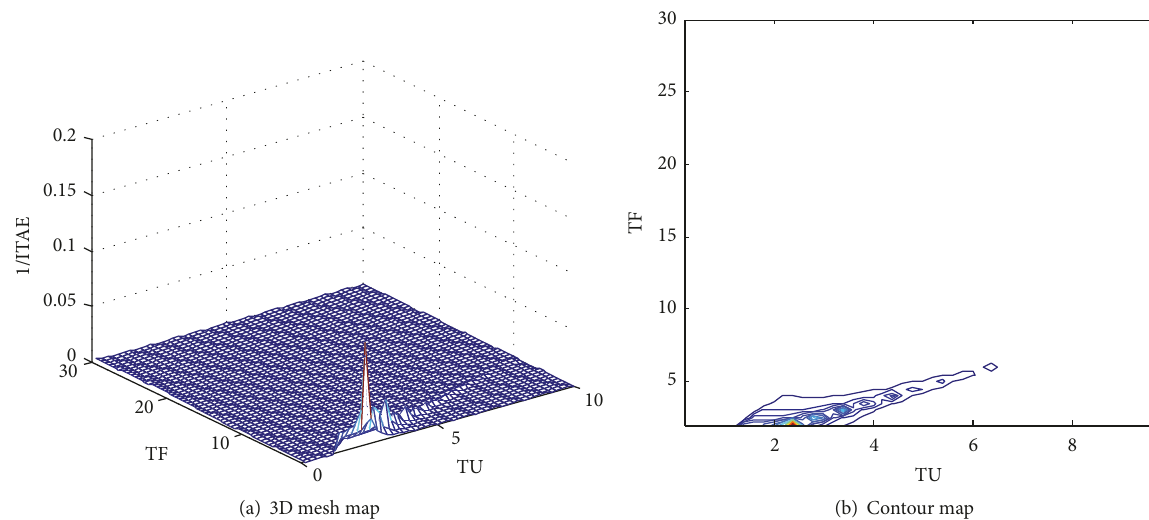
Figure 8: 1/ ITAE of nonlinear handling chain